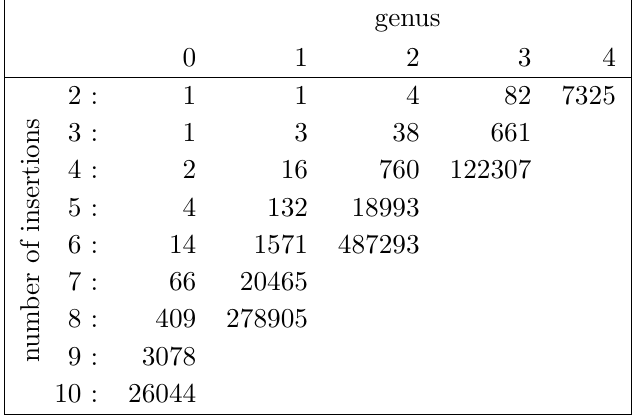
Table 1 . Numbers of maximal graphs for various genera and numbers of insertions. Here, the vertices of the graphs are unlabeled, i.e. all vertices are treated as identical. graphs on the left in (cid:12)gure 9 can be represented in Mathematica as graph[v[1,2], v[1,3], v[2,4], v[3,4]] graph[v[1,2,3], v[1,4,2,5,6], v[3,7,8],